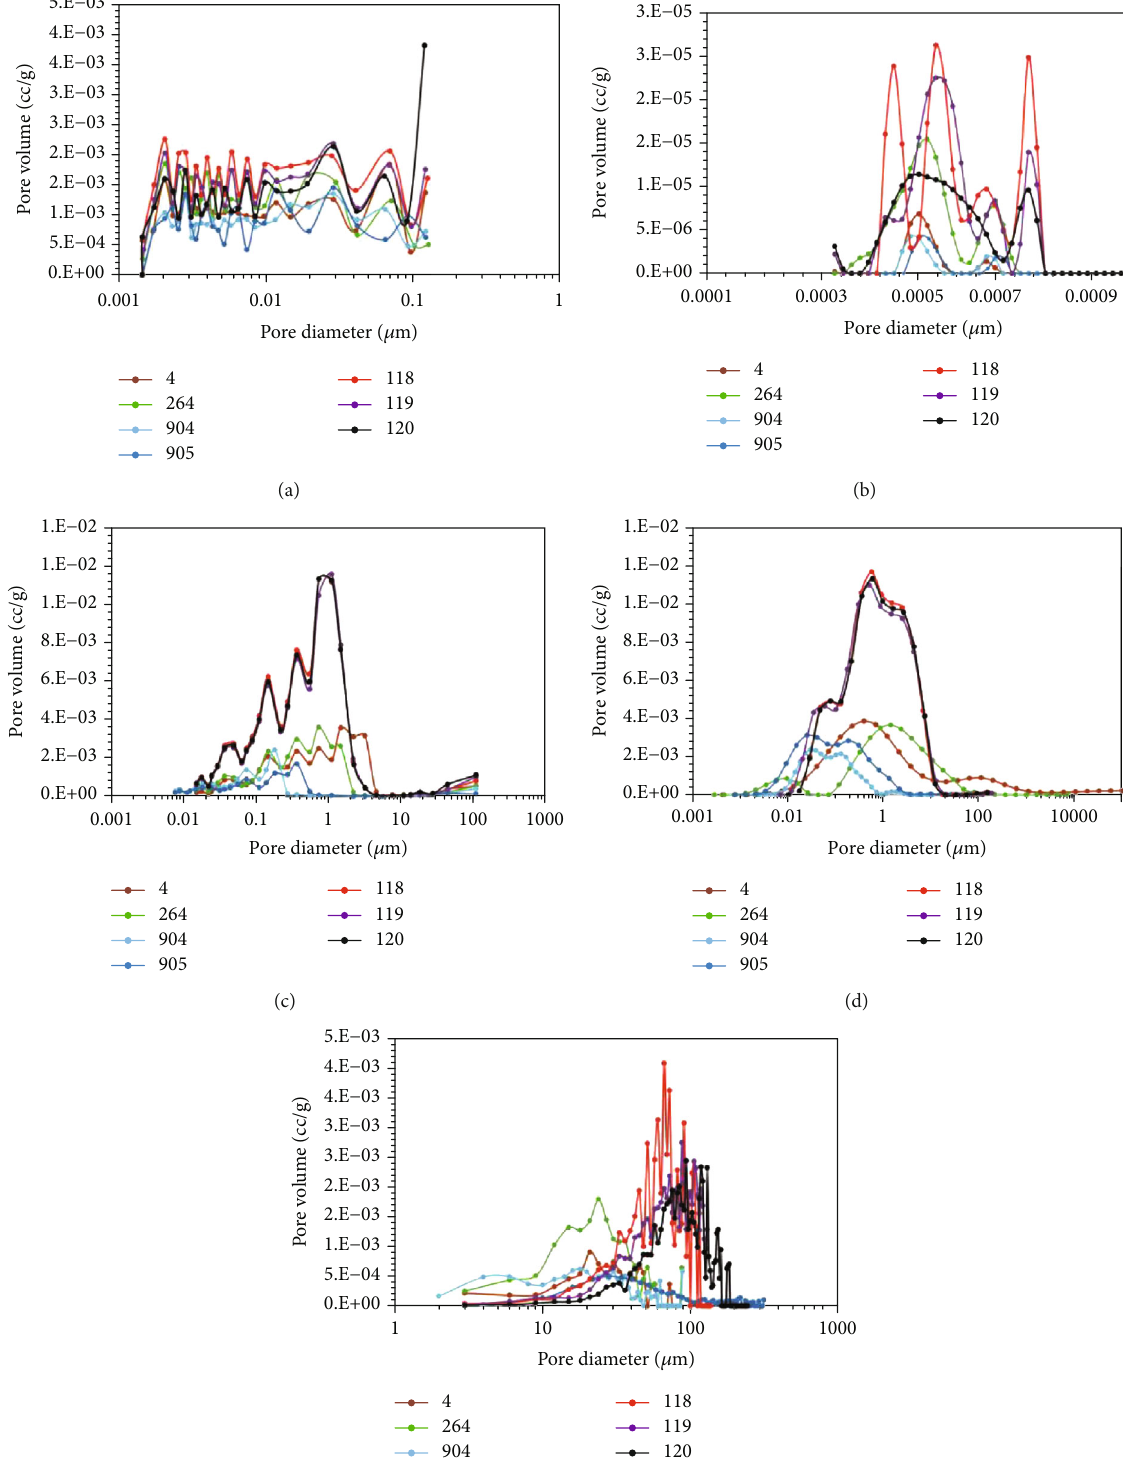
Figure 11: Comparison of the PSD curves derived from N -LPAI. (b) PSD curves derived from CO derived from N 2 (e) PSD curves derived from